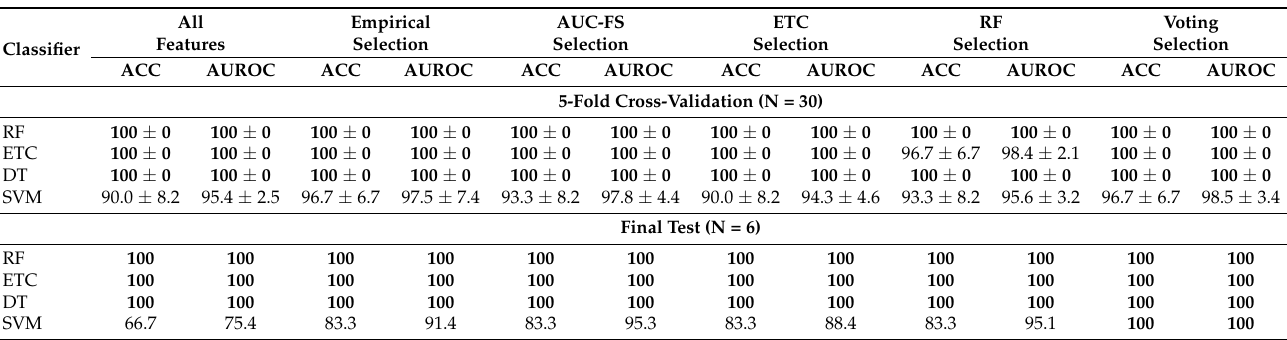
Table 4. Multimodal classification performance (%) between control vs. chronic infection groups. Cross-validation results are expressed as mean and standard deviation. The best performances are presented in bold.